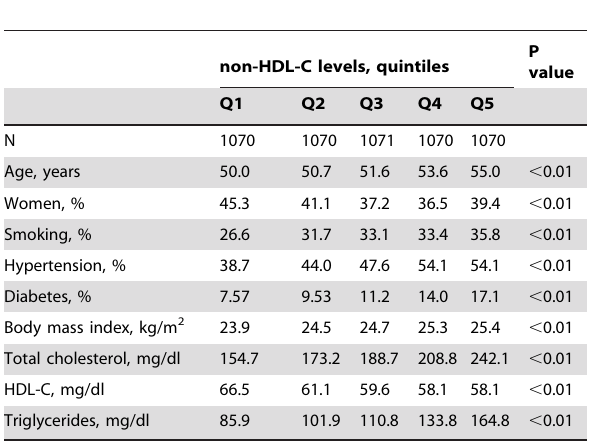
Table 1. Median baseline characteristics of participants according to non-HDL-C quintiles.